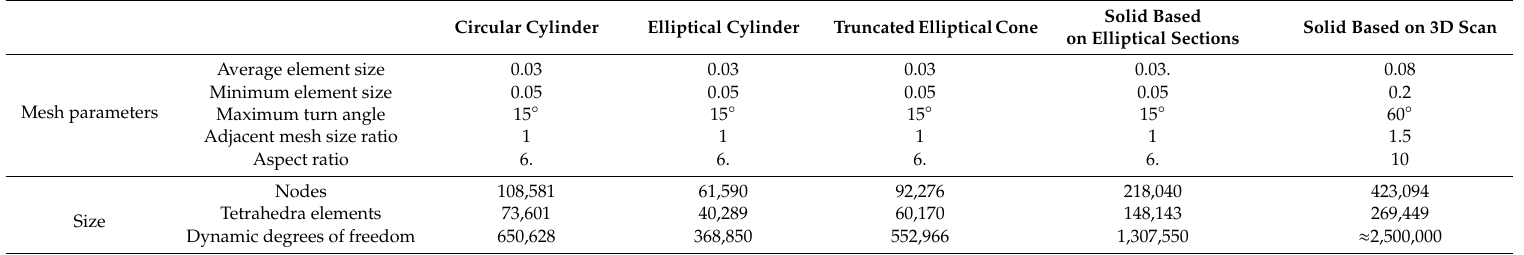
Table 1. Size and parameters for the Finite Element